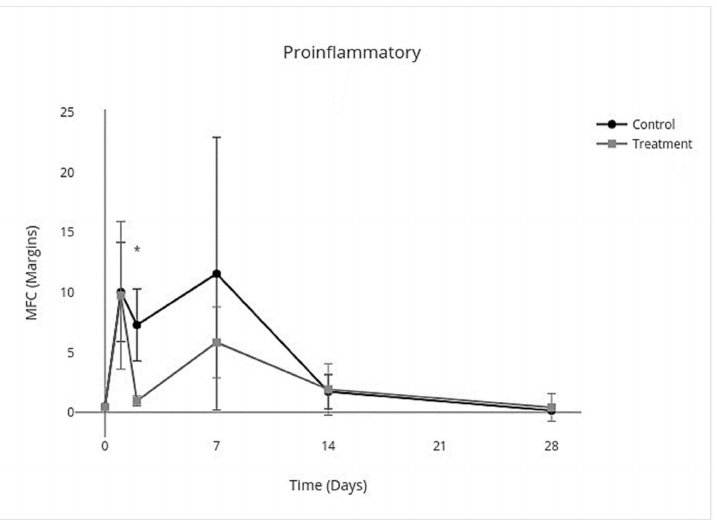
Figure 7. MFC of mRNA expression of proinflammatory cytokines over time following IV allo-CB- MSC therapy. In the treatment group, there was an overall treatment effect over all days, characterized by decreased expression of proinflammatory cytokines with an individual significant treatment effect on day 2 ( p = 0.03). (*) = p < 0.05.